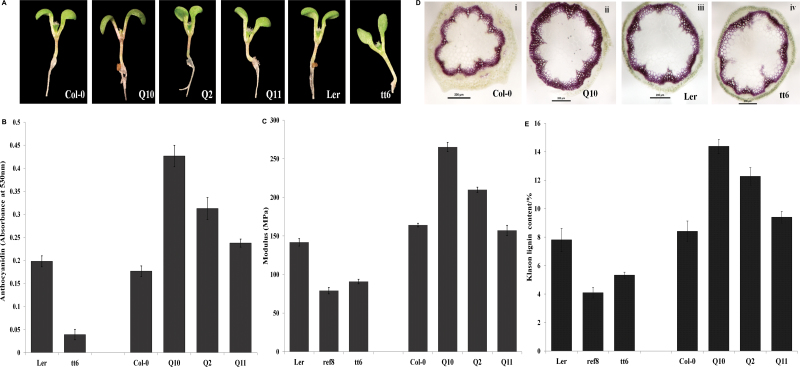
Phenotypes associated with QuoA transgene expression in transgenic lines. (A) QuoA transgenic seedlings showing accumulation of anthocyanidins. The tt6 mutant, which does not produce anthocyanidins, was used as a control. (B) Anthocyanidin quantification in 6-day-old QuoA transgenic seedlings. Anthocyanidins were extracted using acidified methanol and absorbance was measured at 530nm. WT Col-0 and tt6 seedling are shown as controls. All experiments were repeated three times, and results are shown as mean±SEM based on three replications (all significant at P<0.01). (C) Young’s modulus of stem internodal segments. Plants (n=5) were subjected to a displacement speed of 0.5mm min–1 until the stem reached their break point in a tensile tester. Maximum load and extension at breaking point were measured and modulus calculated as stress over strain in MPa. The results are shown as means±SEM based on nine replications (all significant at P<0.0001). (D) Phluoroglucinol staining of lignin in stem cross- sections of WT Columbia (Col-0), QuoA transgenics (Q10), WT Landsberg (Ler), and the tt6 mutant. Infloresence stems from 5-week-old QuoA transgenic lines were sectioned and stained with phloroglucinol/HCl. All images were taken at ×80 magnification under a dissection microscope with bright-field illumination. (E) Klason lignin content analysis of 5-week-old Arabidopsis transgenic stems. The results are shown as means±SEM based on five replications (all significant at P<0.01).